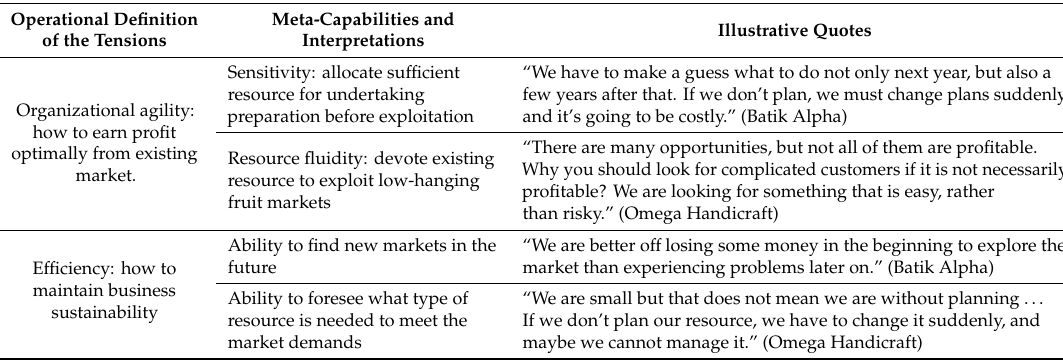
Table 2. Long and short-term orientation